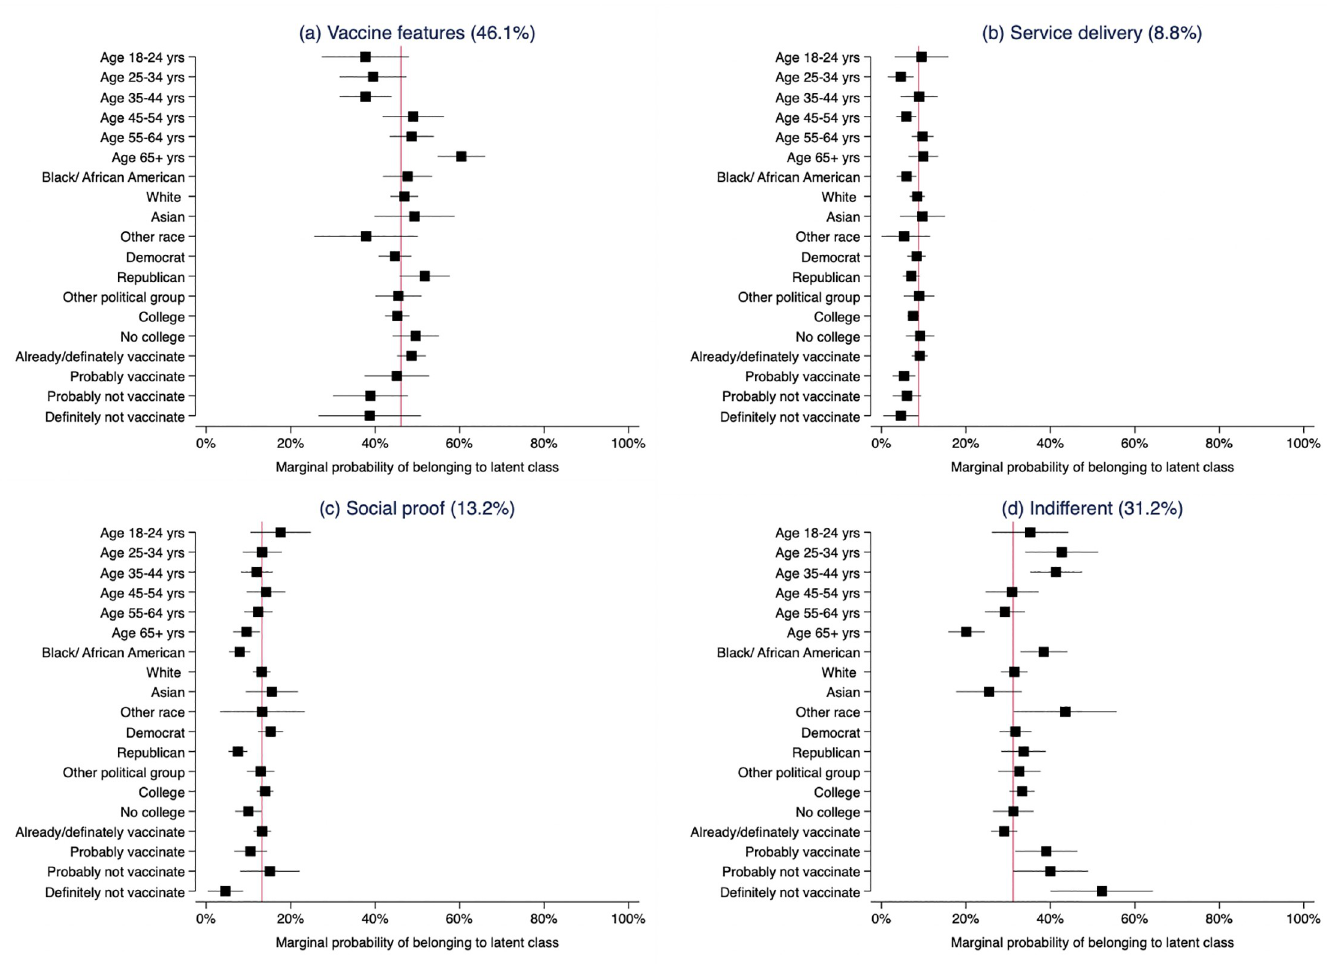
Fig 5. Marginal probability of belonging to latent class group by demographic characteristics and vaccination intention. The red x-line represents overall probability of class membership in the population. “Vaccine features” group includes “single dose”, “two-dose” and “vaccinate once” latent classes.